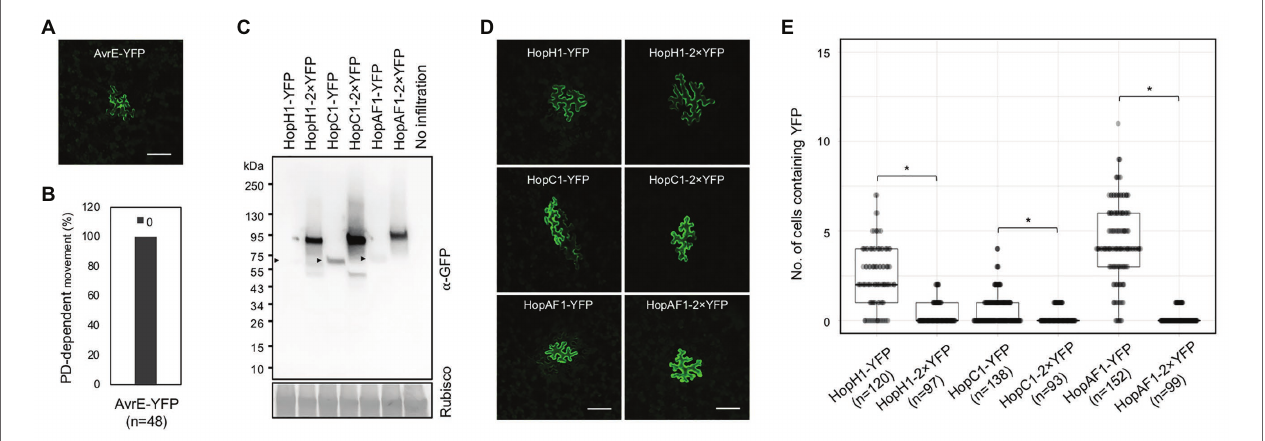
FIGURE 2 | The movement of effectors is largely affected by their sizes. (A) Confocal image shows the expression of AvrE-YFP. Scale bars = 100 μ m. (B) Quantitative data show that AvrE-YFP cannot move through PD. 0: no diffusion. The number of transformation events analyzed is indicated ( n ). (C) Detection of full-length effector fusion proteins. Effector-YFPs and effector-2×YFPs were transiently expressed in N. benthamiana . The samples were then subjected to immunoblot analysis using an anti-GFP antibody. Rubisco is served as a loading control. Arrow heads indicate the expression of effector-YFPs. (D) Confocal images show the diffusion of effector-YFP fusion proteins. Images were taken from epidermis of N. benthamiana transiently expressing different fusion proteins. Scale bars = 100 μ m. (E) Quantitative data present the plasmodesmata (PD)-dependent movement of effector-YFP fusion proteins. Mann-Whitney U Test was used to analyze the data. The p -value is <0.0001 for HopH1-YFP vs. HopH1-2×YFP, <0.00094 for HopC1-YFP and HopC1-2×YFP, and <0.00001 for HopAF1-YFP and HopAF1-2×YFP (*). The number of transformation events analyzed is indicated ( n